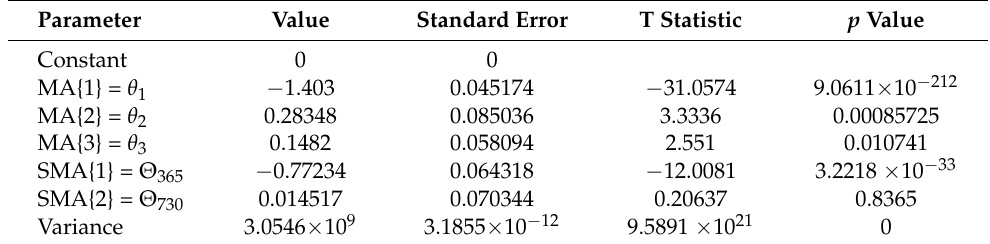
Table 3. Model estimation results for SARIMA(0,1,3)(0,1,2)[365] Model.